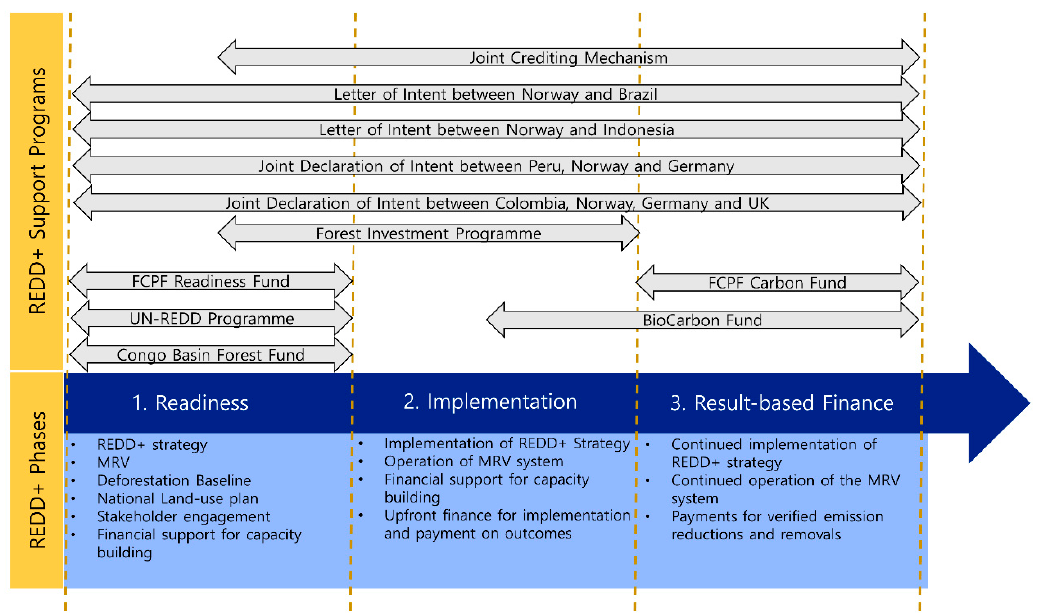
Figure 1. Reducing emissions from deforestation and forest degradation, and the role of conservation, sustainable management of forests, and enhancement of forest carbon stocks in developing countries (REDD + ) phases and support programs (modified from